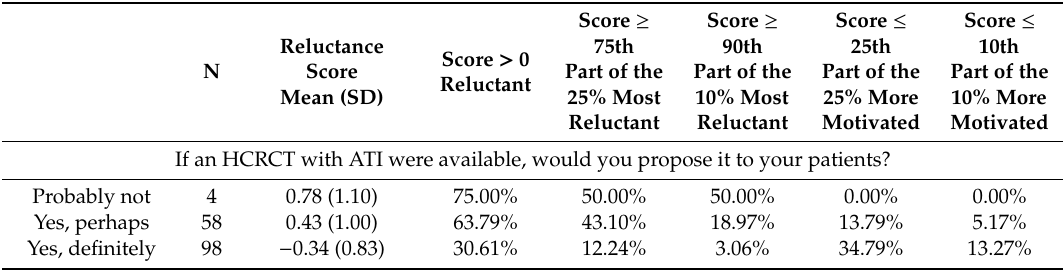
Table 1. Distribution of answers to the direct question according to the reluctance score ( n = 160). HCRCT: HIV cure-related clinical trials and ATI: antiretroviral treatment